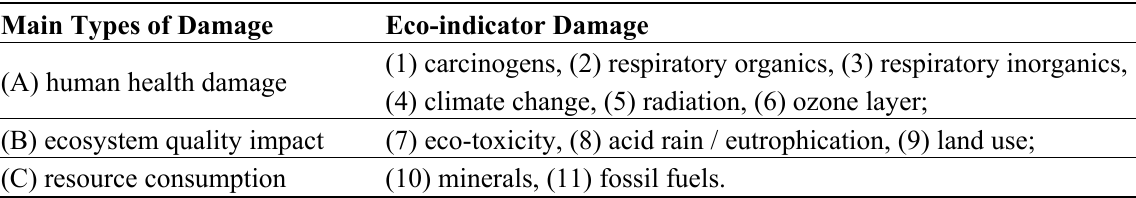
Table 3. The 11 “damages” grouped in three main